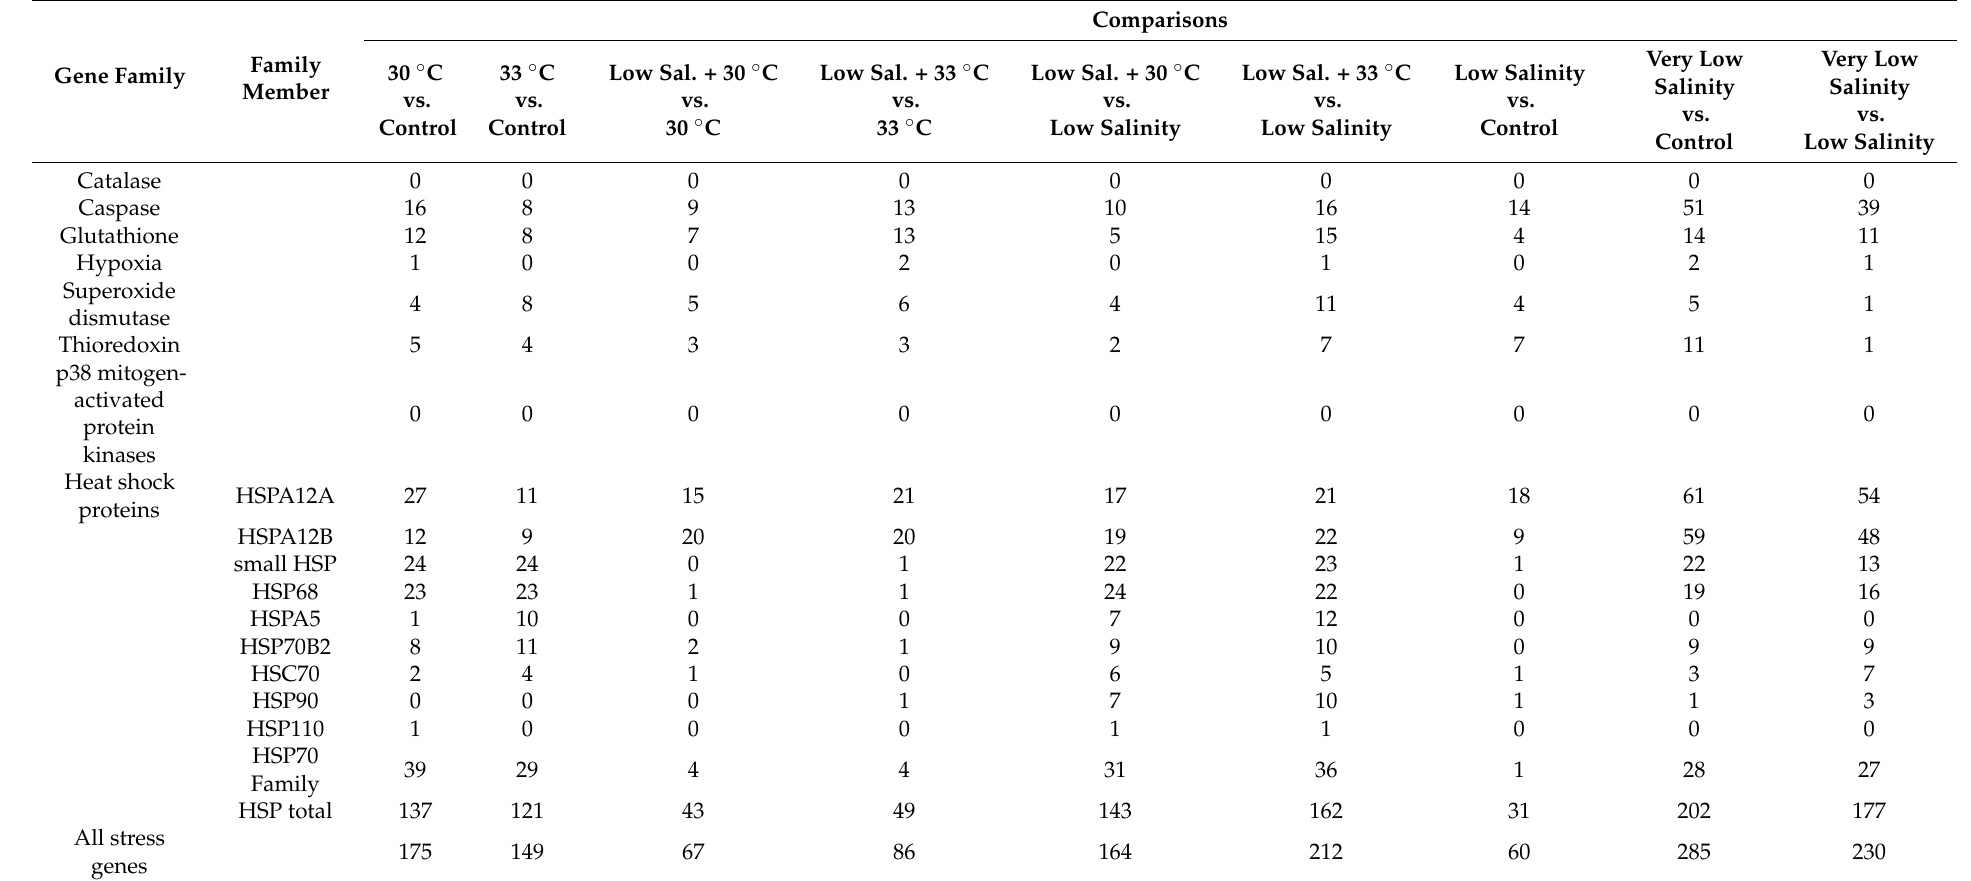
Table 4. Upregulated stress response genes in blue mussels ( M. edulis ) identified in differentially expressed gene lists from the different treatment comparison, using the SwissProt and NR database